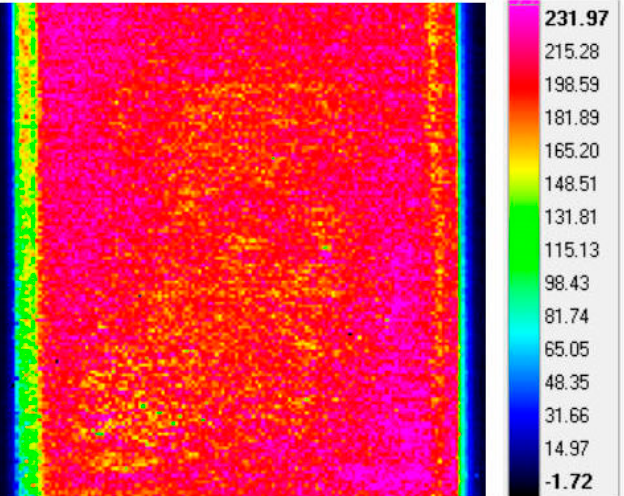
Figure 13. The bulk stress field at a load of 38.1kN and R = 0.1 for a specimen repaired with a 6061 powder coating.